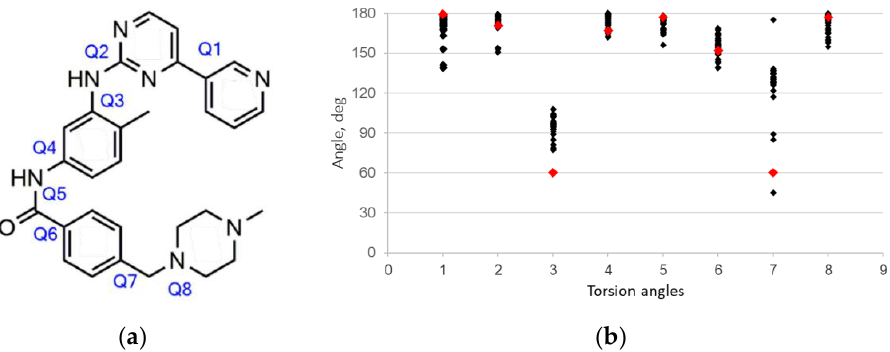
Figure 1. ( a ) Schematic representation of a freebase Imatinib . Q1 – Q8 denote torsion angles. ( b ) Modules of Q1-Q8 angles of Imatinib in previously reported (black) and freebase (red) compounds in the extended conformation.